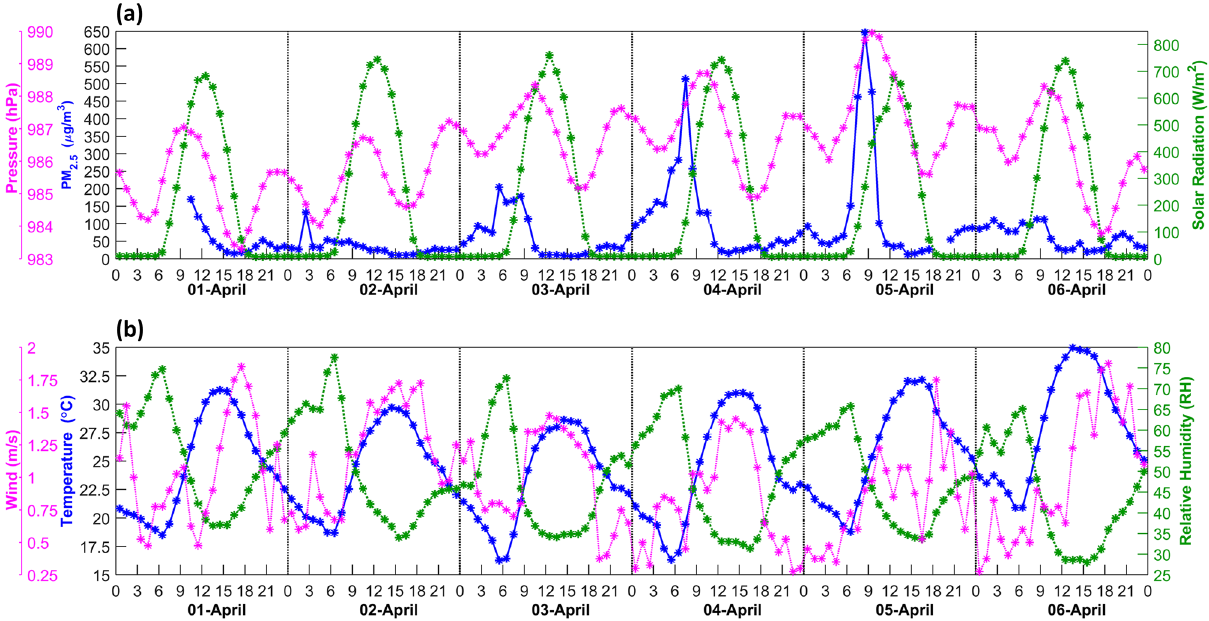
Figure 4. Upper panel ( a ) Hourly averaged PM 2.5 concentration based on Compact Useful Particle Instrument (CUPI) monitoring at Dwarka. Solar radiation (W m −2 ), barometric pressure (hPa) are also shown. Lower panel ( b ) illustrates temperature (°C), relative humidity (%) and wind speed (m s −1 ). Rest all other fields are monitored at Dwarka DPCC station (~ 3 km away from CUPI monitoring point) and shown during second week of locked down period (from 1 to 6 April